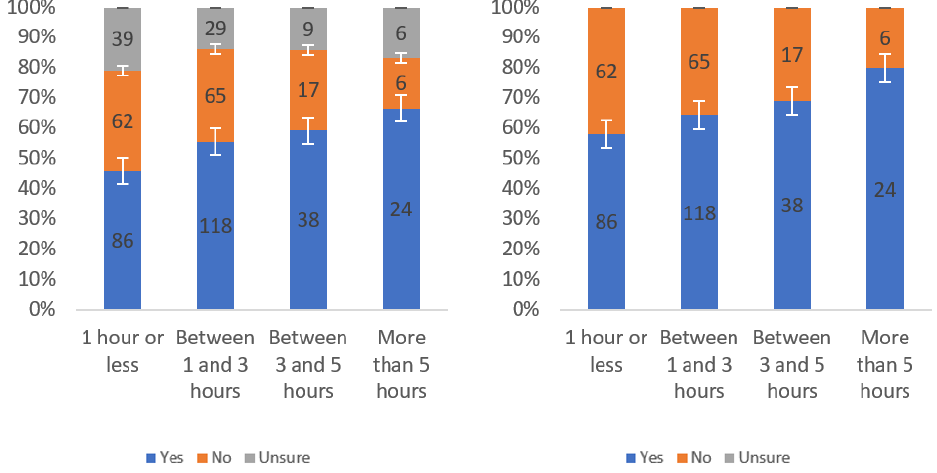
Figure A9. Responses regarding respondents’ willingness to review by internet usage level including ( left ) and excluding ( right ) unsure responses.